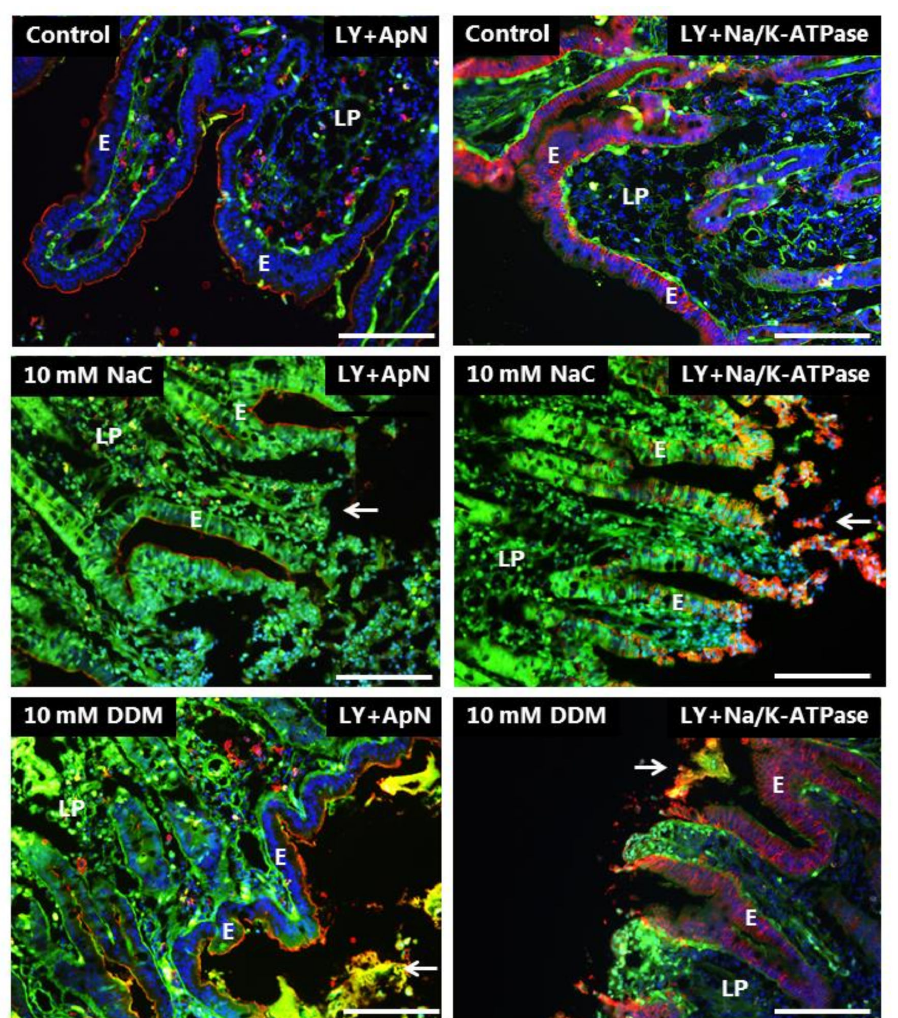
Figure 6. Permeability of the mucosal epithelium probed with LY at 10 mM concentration of PEs. Sections of mucosal explants cultured for 1 h with LY in the absence or presence of 10 mM NaC or DDM, respectively. In addition, the sections were immunolabeled for ApN, or Na + /K + -ATPase, a basolateral cell membrane marker. Both NaC and DDM caused extensive denudation at the tips of the villi (arrows), but epithelial integrity with preservation of cell membrane polarity was maintained along the sides of the villi. However, all enterocytes had taken up LY into the cytosol. Bars: 20 µ